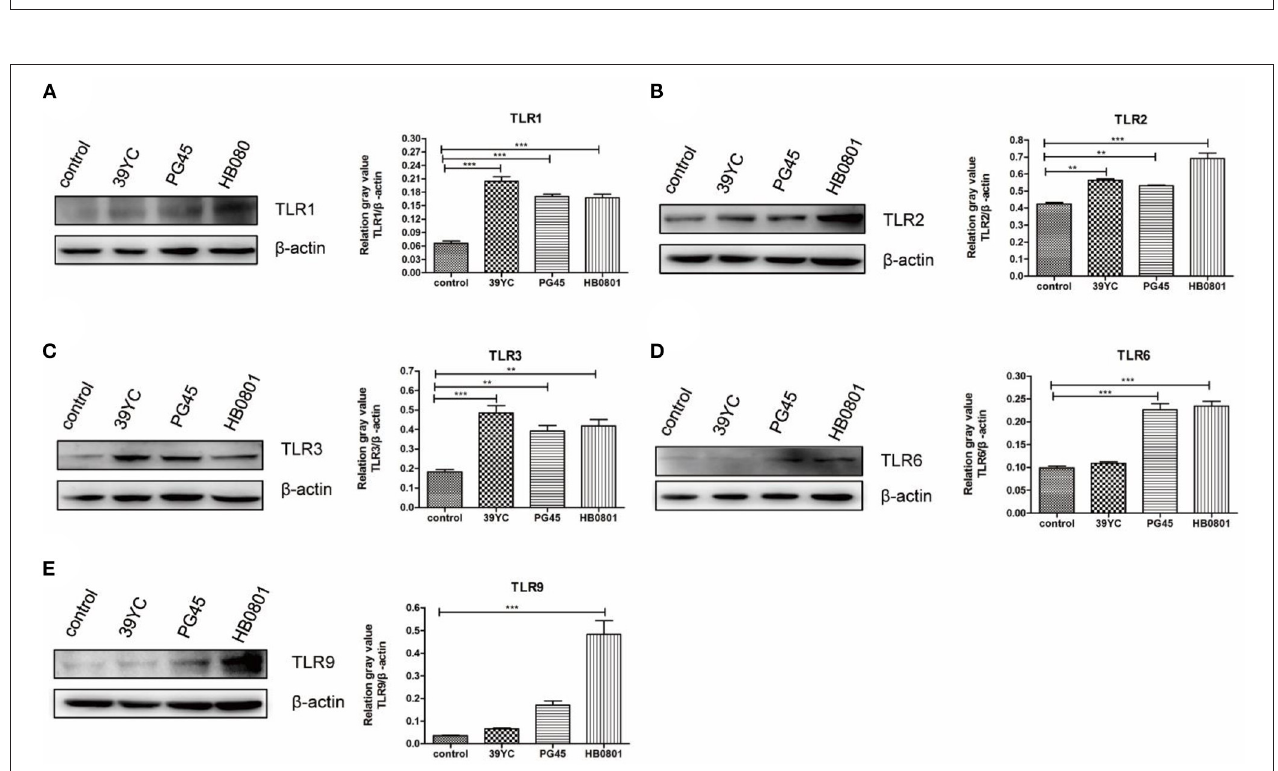
FIGURE 3 | M. bovis activated TLRs expression in BMECs. (A–E) The protein expression of TLR1, TLR2, TLR3, TLR6, and TLR9 from BMECs infected by M. bovis, (A) 20h post-infection (hpi), (B–D) 16 hpi, (E) 20 hpi. ** p < 0.01, and *** p < 0.001.